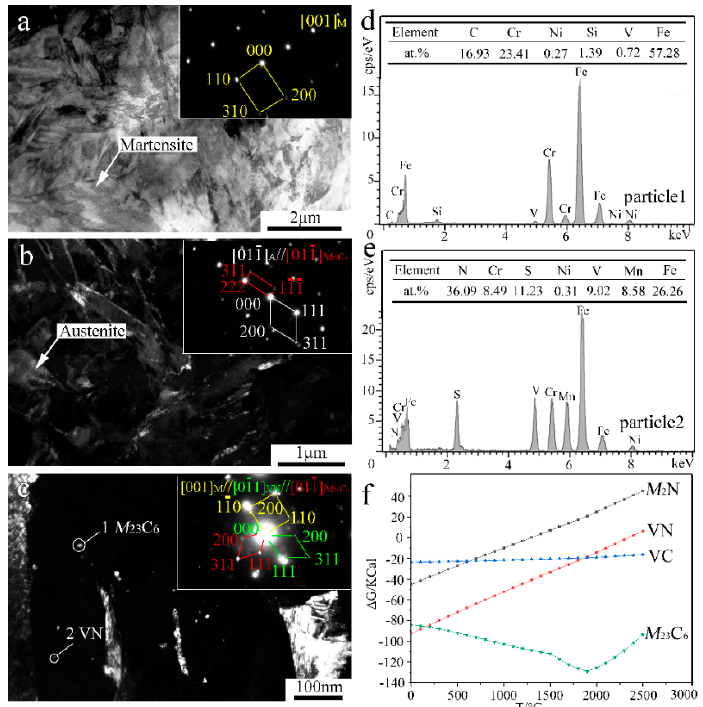
Figure 4. TEM results of the V-free MSS coating: ( a ) Bright-field (BF) image and SAED pattern of M; ( b ) Dark-field (DF) image and SAED pattern of A; ( c ) DF image and SAED pattern of M 23 C 6 ; ( d ) EDS analysis of martensite; and ( e , f ) EDS analysis of particles 1 and 2 denoted in ( c ), respectively.